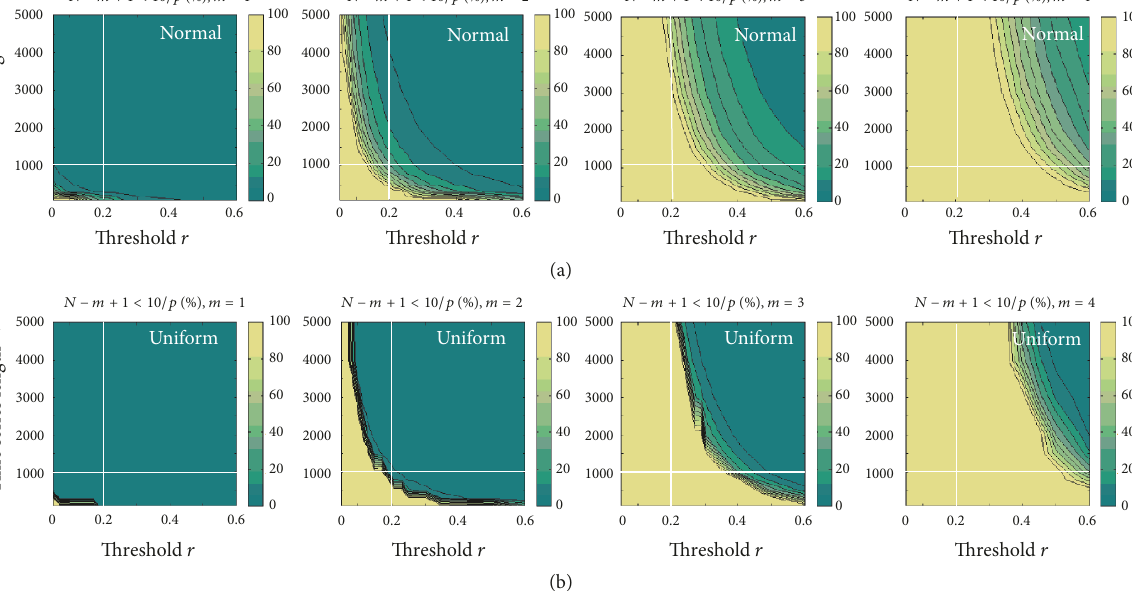
Figure 4: Percentage of estimates ̂𝑝 𝑚 𝑖 (𝑟) in artificial data that fail to satisfy the criterion 𝑁 − 𝑚 + 1 ≥ 10/̂𝑝 𝑚 𝑖 (𝑟) [ % ] , presented in threshold- length ( 𝑟 - 𝑁 ) plane, for 𝑚 = 1,2, 3, 4 ; failures are presented by color changes from green (0% failures) to yellow (100% failures); (a) X and Y normally distributed; (b) X and Y uniformly distributed; white horizontal and vertical lines cut each plane at typical parameter values 𝑟 = 0.2 and 𝑁 = 1000